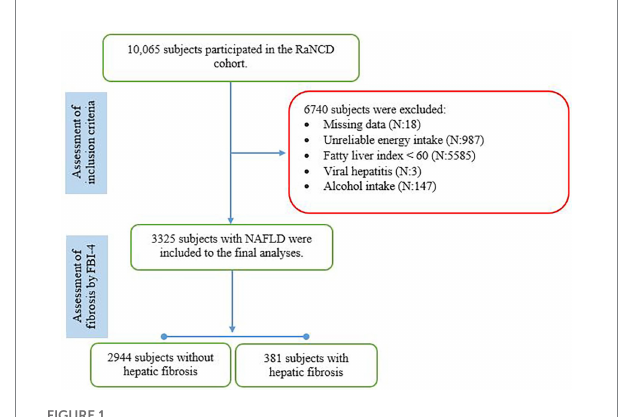
FIGURE 1 The flow chart of the